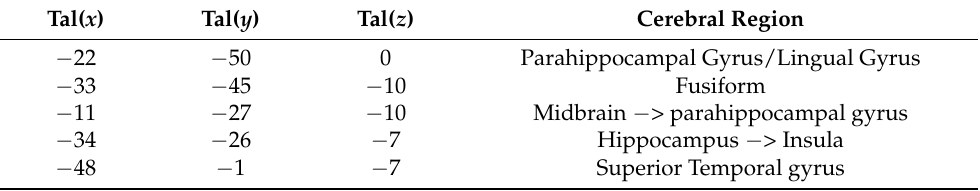
Table 6. Clusters of brain activation where the significantly greater correlation between the number of A alleles of the AKT1 rs1130233 polymorphism under THC condition than under placebo condition while viewing fearful faces may be mediated by correlation with methylation percentage at CpG island 11–12 around rs1130233 polymorphism in the AKT1 gene. L and R indicate the left and right